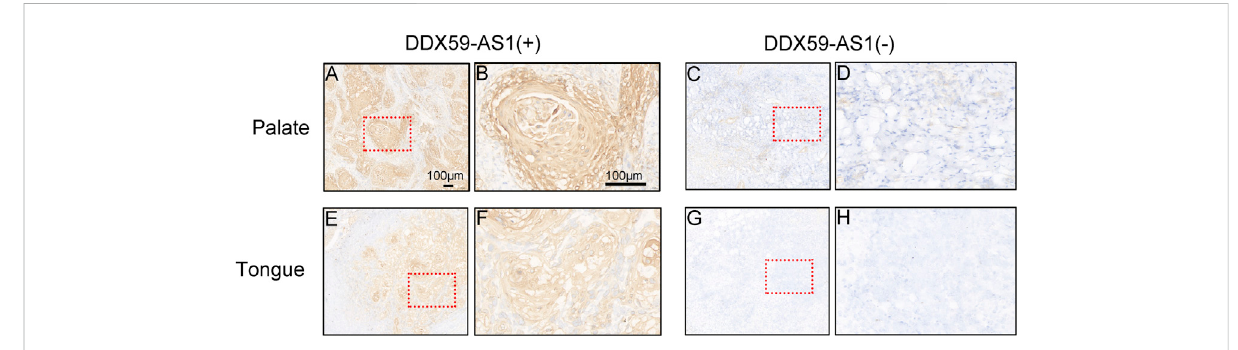
FIGURE 3 Expression ofDDX59-AS1inOSCCandadjacenttissues. (A – B) Expression ofDDX59-AS1inpalate carcinoma; (C – D) Expression ofDDX59-AS1 in the adjacent palatal tissue; (E – F) Expression of DDX59-AS1 in tongue cancer tissue; (G – H) Expression of DDX59-AS1 in tongue adjacent